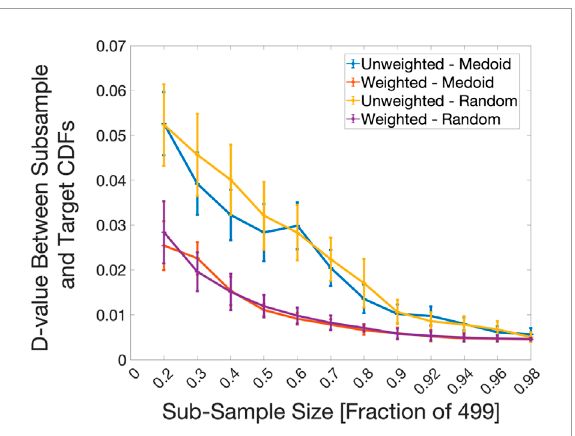
FIGURE 8 D-value versus sub-sample size trend for the Taylor-Anvil simulations. A comparison of the convergence to the target distribution between random sub-sample selection with PLOW applied (Weighted-Random), random sub-sample selection without PLOW (Unweighted-Random), k-medoids sub-sample selection with PLOW applied (Weighted - Medoid), and k-medoids sub-sample selection without PLOW (Unweighted - Medoid) are shown. The sub-sample size represents the number of input points used to construct the proposal distribution. At each X -axis interval, 100 2-Sample K-S statistic values (D-values) were calculated between the target distribution and a proposal distribution constructed using a different drawing of points from the pool of 499 total input points. The average and standard deviation of the 100 D-values is